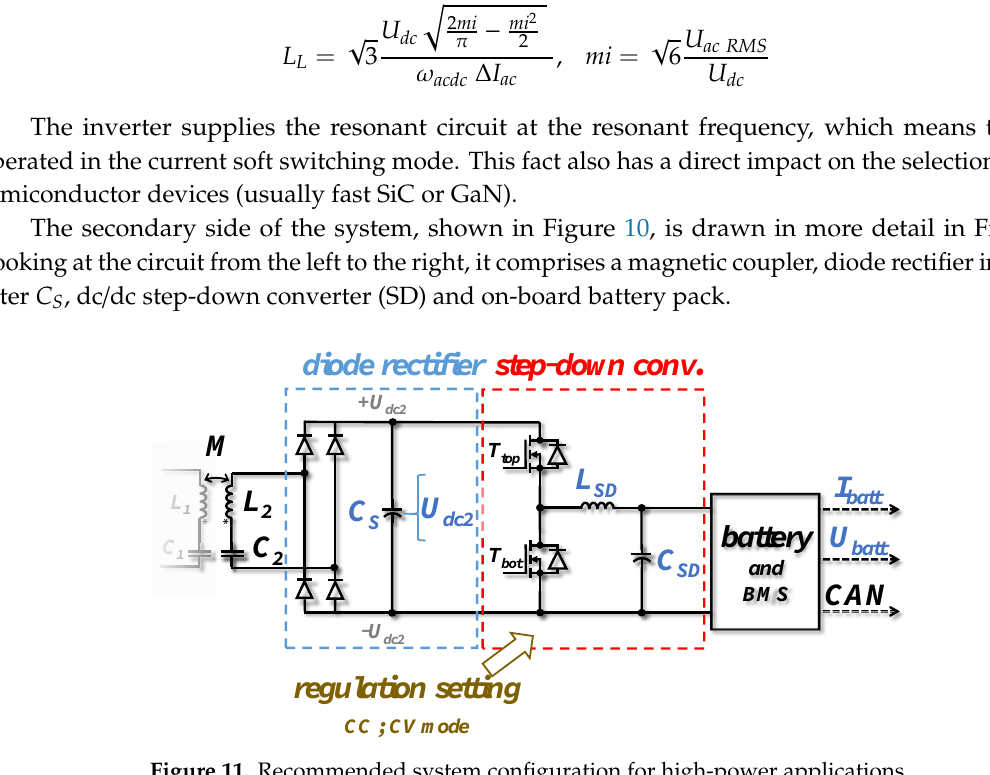
Figure 11. Recommended system configuration for high-power applications.